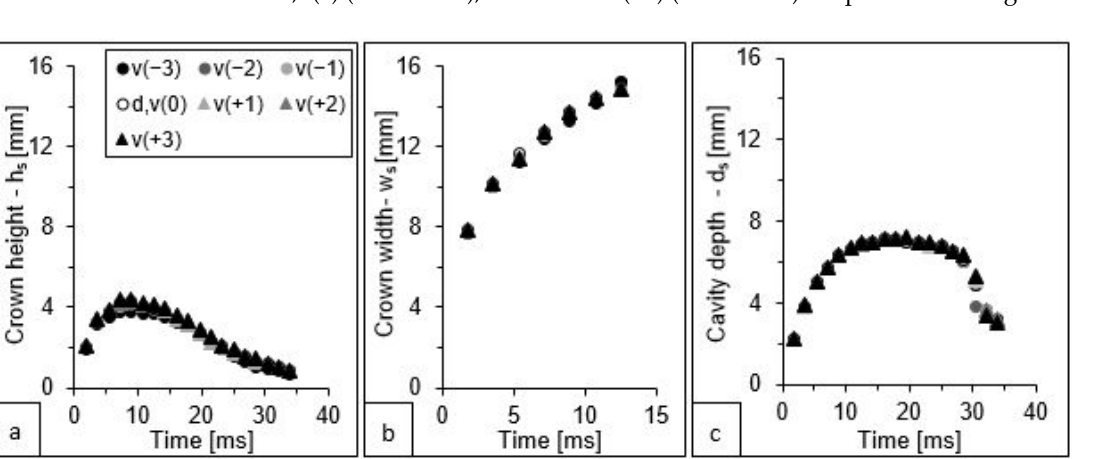
Figure 8. Change in the three splash parameter values: ( a ) height of the crown —h s , ( b ) external width of the crown arms—w s , and ( c ) depth of the cavity below the water surface —d s , presented in the subsequent moments of the splash phenomenon for seven simulations differentiated by the velocity of the falling drop.